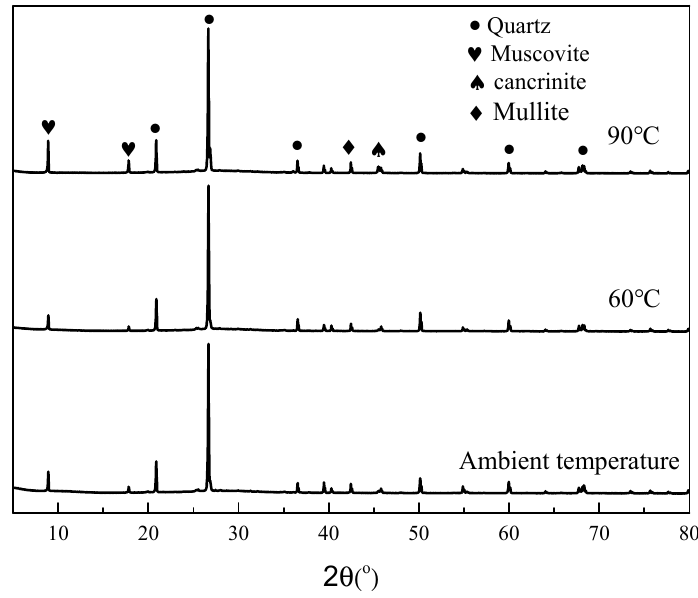
Figure 10. XRD curves of HMGCs under different curing temperatures.